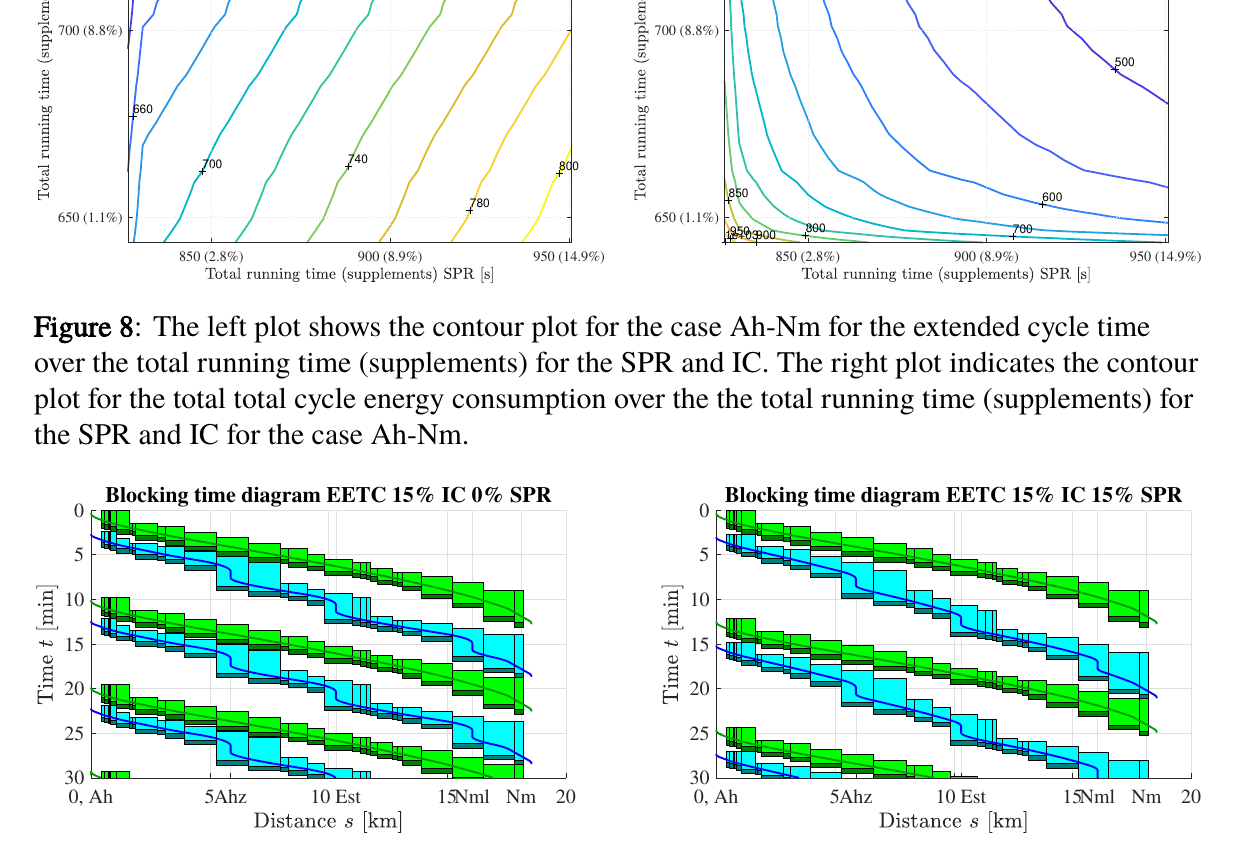
Figure 9: The left plot shows for the case Ah-Nm for the IC (green) and SPR (blue) compressed blocking time diagram for the EETC driving strategies with 15% running time supplements for the IC and 0% running time supplements for the SPR. The right plot indicates the IC (green) and SPR (blue) compressed blocking time diagram for the case Ah-Nm for the EETC driving strate- gies with 15% running time supplements for both the IC and